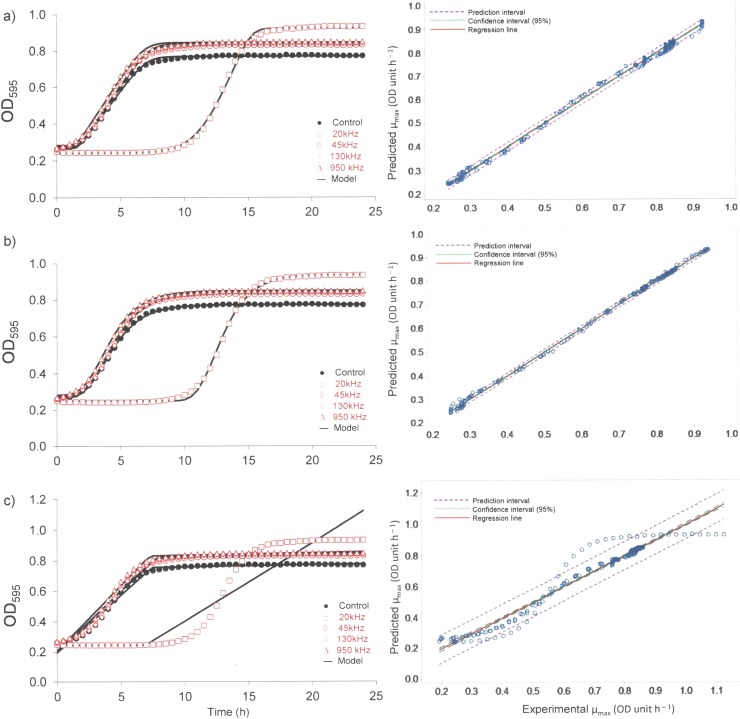
L. sakei growth curve plot as measured by optical density over a 25 h incubation at 30°C following various ultrasound treatments plotted using Scale free (a), Gompertz (b) and Biphasic models (c) and corresponding model fitting.